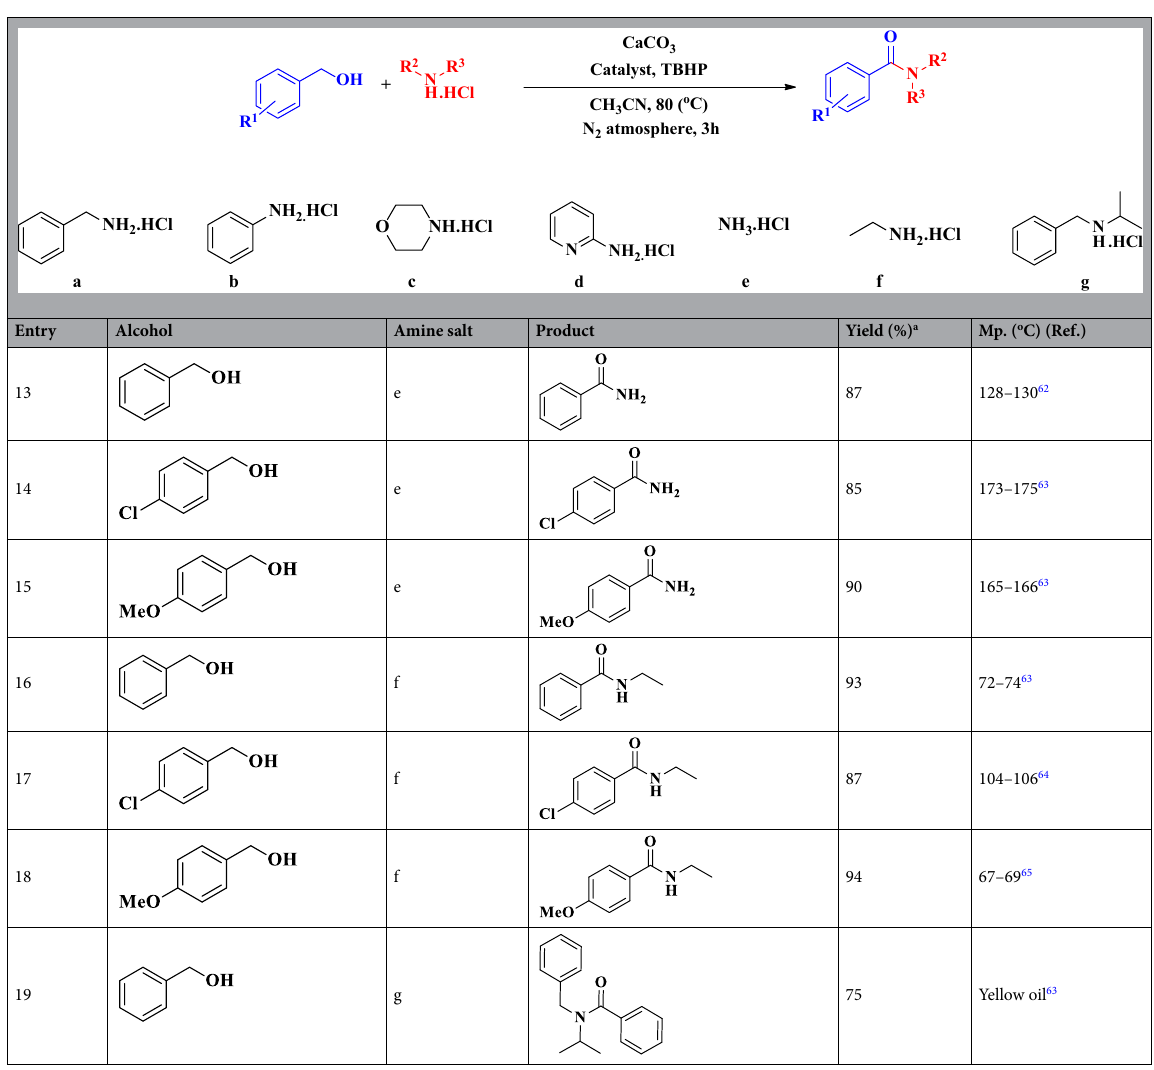
Table 3. Direct oxidative amidation of benzyl alcohols with amine salts. Reaction condition: amine hydrochloride (1.0 mmol), benzyl alcohols (1.5 mmol), Catalyst (CN-Pr-β-CD/Cu(II)) (15 mg), CH 3